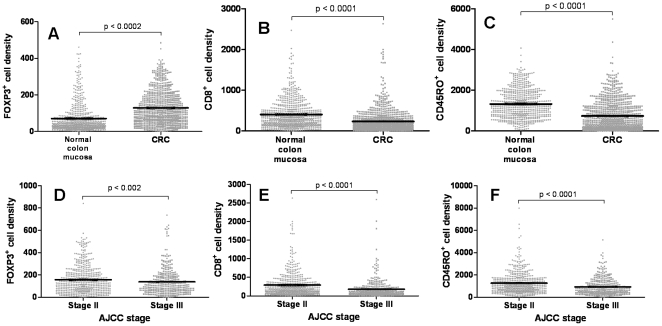
FOXP3, CD8 and CD45RO expression in CRC and their effects on cancer stage and disease outcome.(A) FOXP3 expression was significantly greater in CRC tissue compared to normal colonic tissue, whilst (B) CD8 and (C) CD45RO expression levels were significantly greater in normal colonic tissue compared to CRC tissue. When looking at T cell density and disease stage (D – FOXP3; E – CD8 and F – CD45RO), the expression of all three markers were significantly greater in stage II CRC compared to stage III CRC. Each dot represents one patient and the bars represent the median value ± SEM.